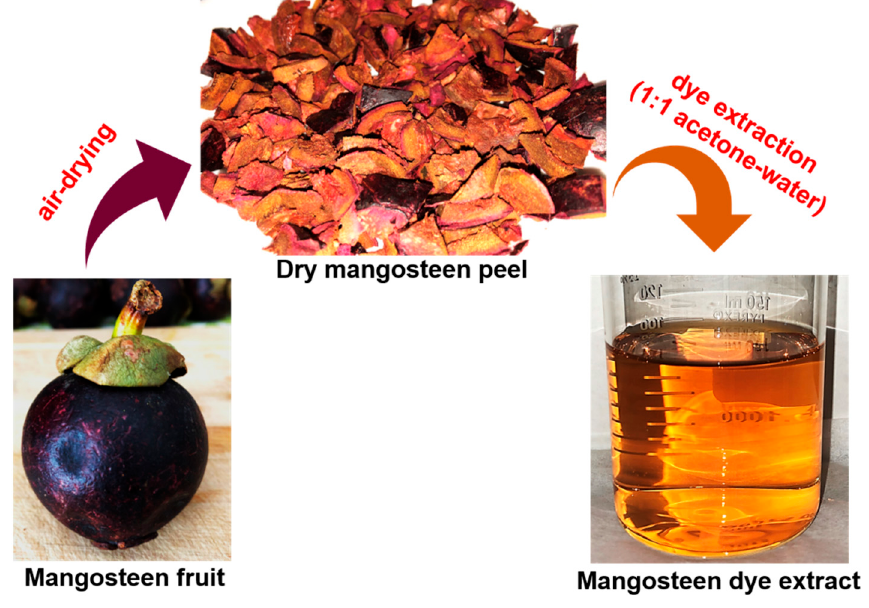
Figure 7. Preparation of mangosteen dye sensitizer.